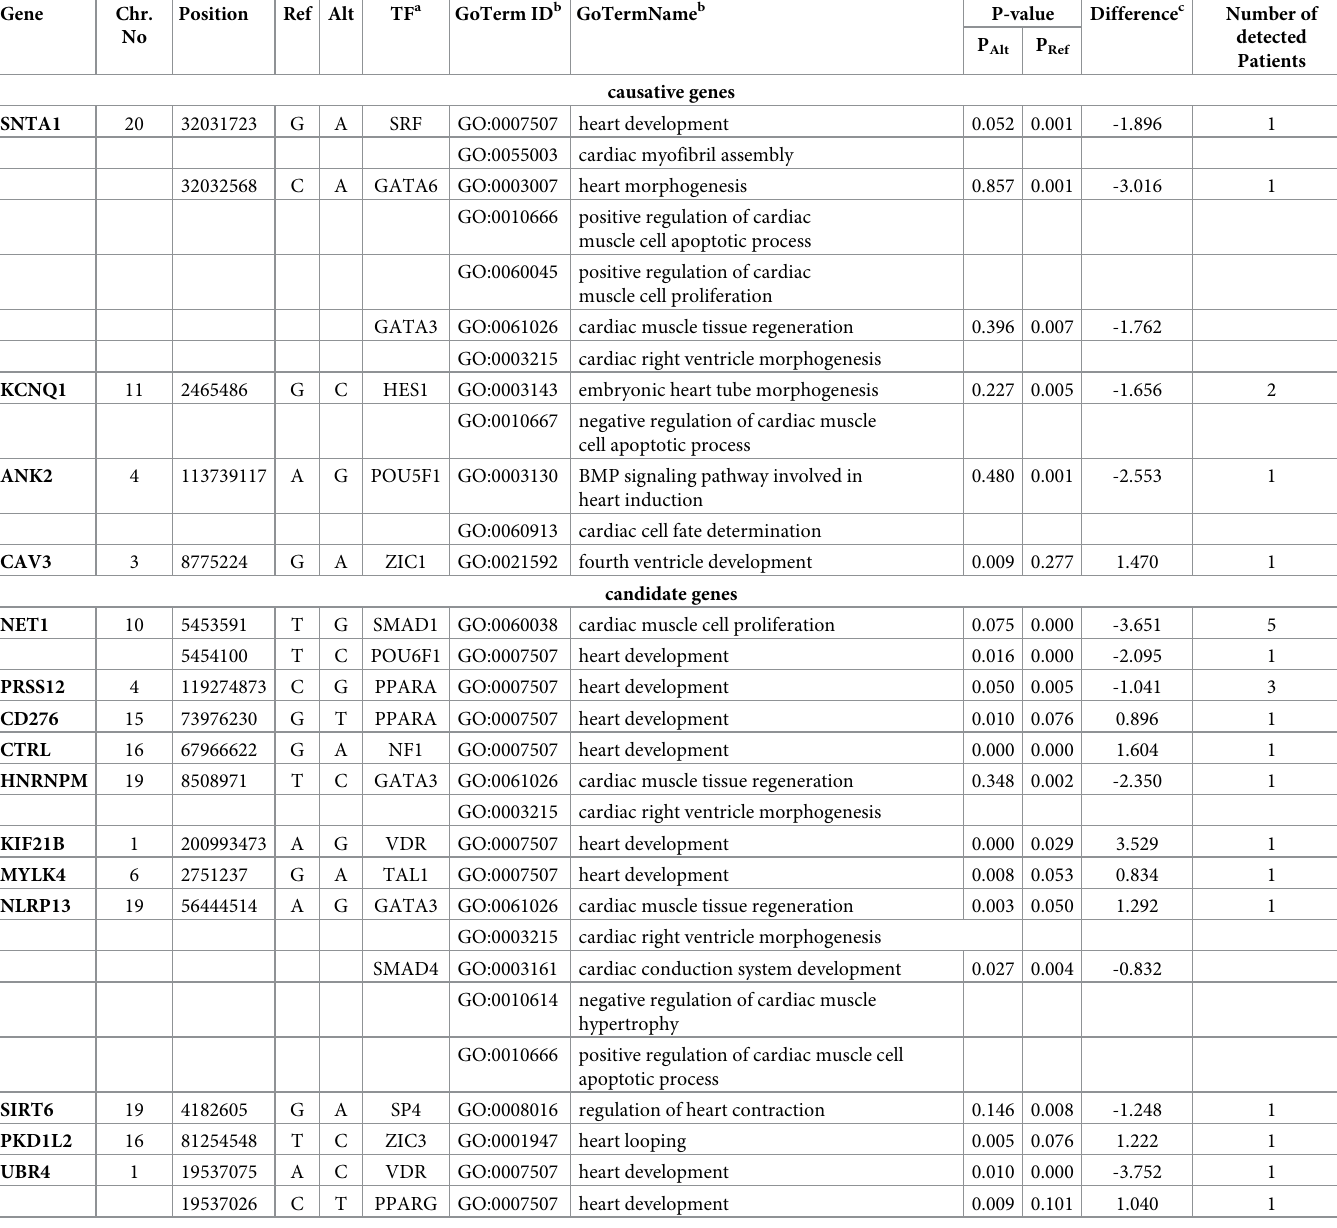
Table 4. Variants in the upstream region that could alter the binding affinity of transcription factors predicted by TRAP. Gene Chr.